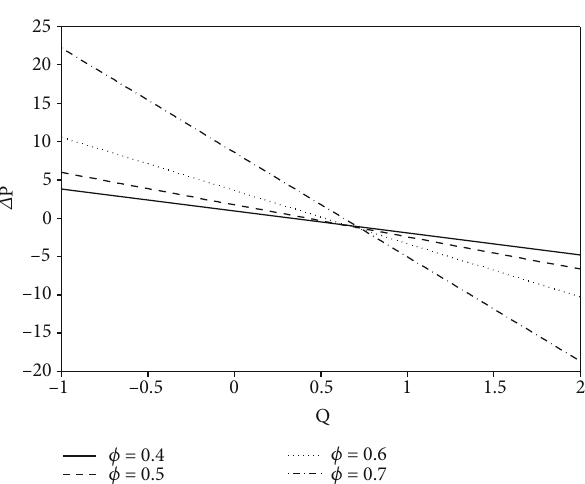
Figure 2: Variation of pressure rise with volume fl ow rate Q for di ff erent values of n for fi xed values of φ = 0 : 8 , We = 0 : 6 , and β = 4 .